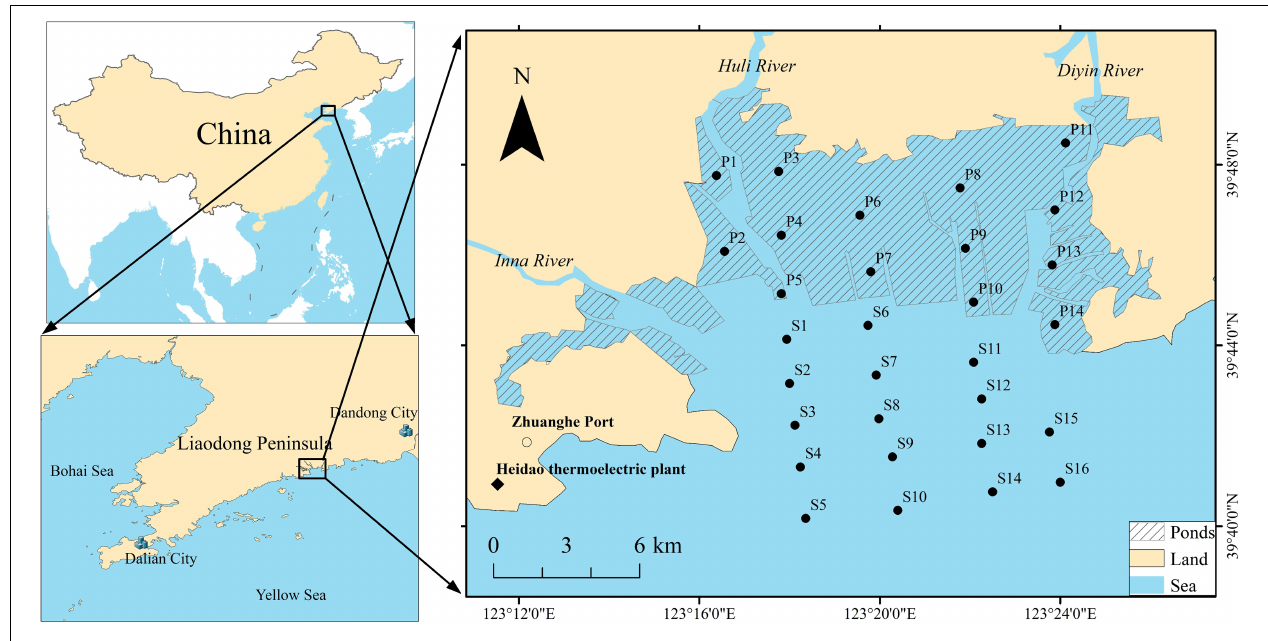
FIGURE 1 | Study area and sampling sites location in Qingduizi